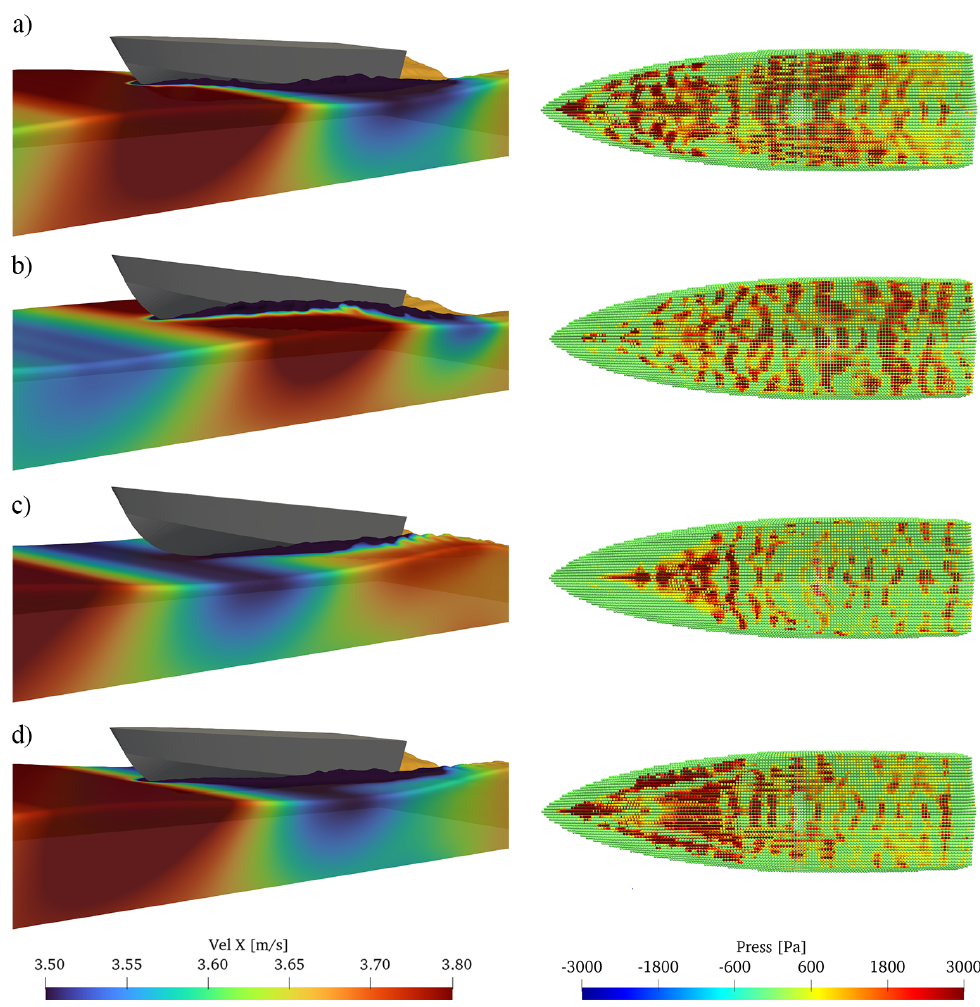
Figure 8. Velocity field of the incoming waves and current and pressure distribution under the hull’s keel in different phases of the hull motion in wave for Case 4 of Table